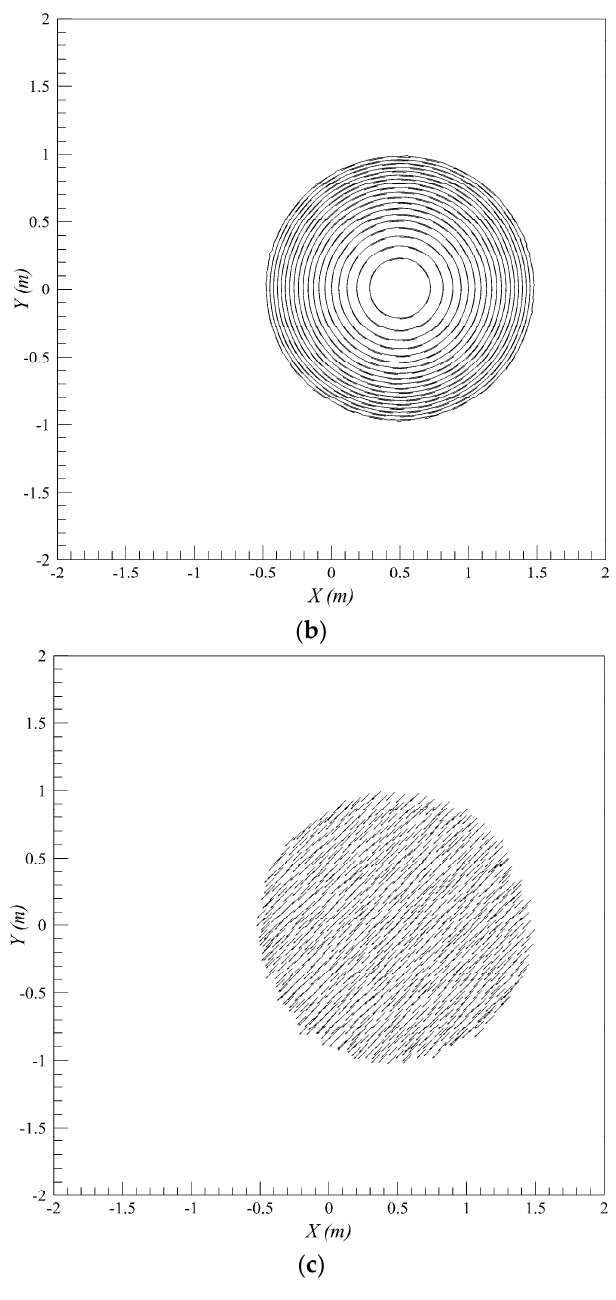
Figure 12. Thacker’s planar solution for water level at 4 T ; ( a ) numerical 3D depth contours; ( b ) comparison of analytical (dashed line) and numerical (solid line) depth contours; ( c ) comparison of velocity vector u for analytical and numerical solutions. Table 2. Grid properties and error ‐ norm for Thacker’s planar solution.